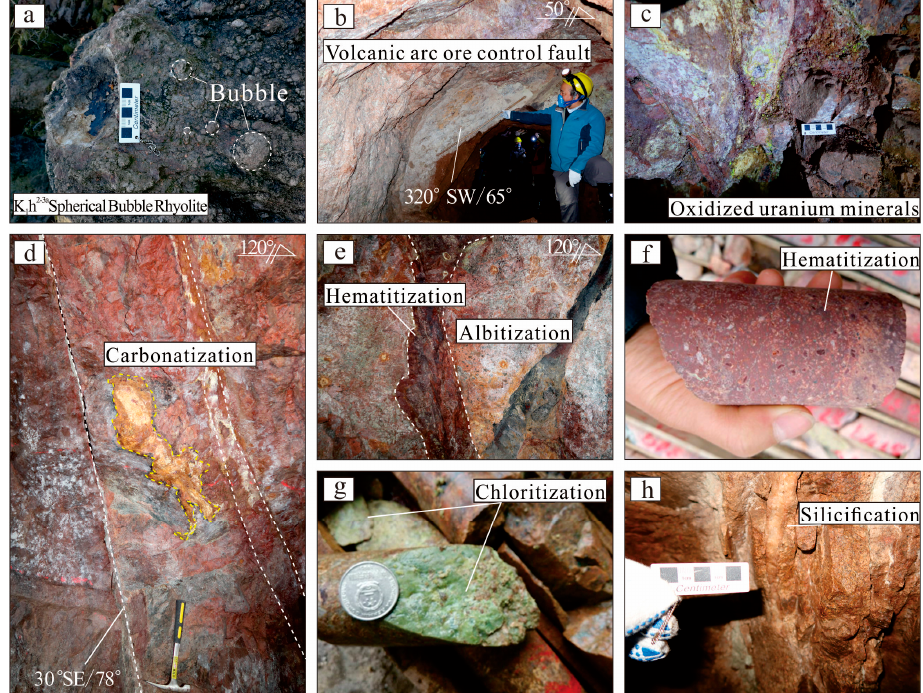
Figure 3. Orebody occurrence characteristics and alteration of the Zhangjiawu uranium deposit, Zhejiang Province, China; ( a ) Lower part of the third lithologic layer (K 1 h 2–3a ) of the unaltered Upper Cretaceous Huangjian Formation; ( b ) NW-trending volcanic arc ore-bearing fractures; ( c ) oxidation of tetravalent uranium minerals to brightly colored hexavalent uranium minerals; ( d ) F10 compression-torsional ore-control fractures with hematite and carbonatization near the fractures; ( e ) hematite mineralization superimposed along the fractures on early sodic feldsparization; ( f ) hematite mineralization; ( g ) chlorite mineralization; ( h ) silicification seen further away from the center of mineralization.